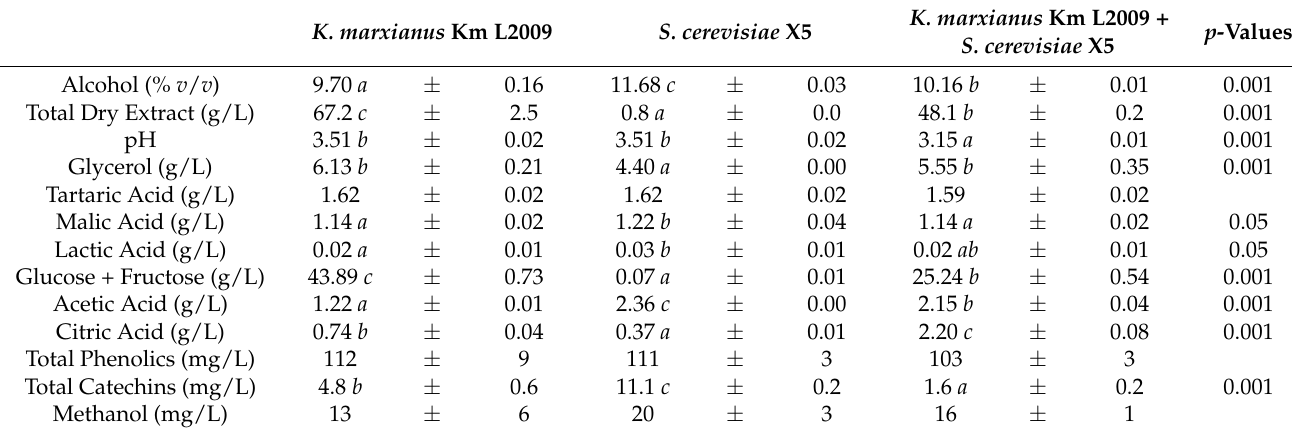
Table 2. The main chemical-physical parameters and statistical data analysis of the laboratory-scale fermentations. Data are reported as average values ± standard deviations of two different vinifications, each with measurements in